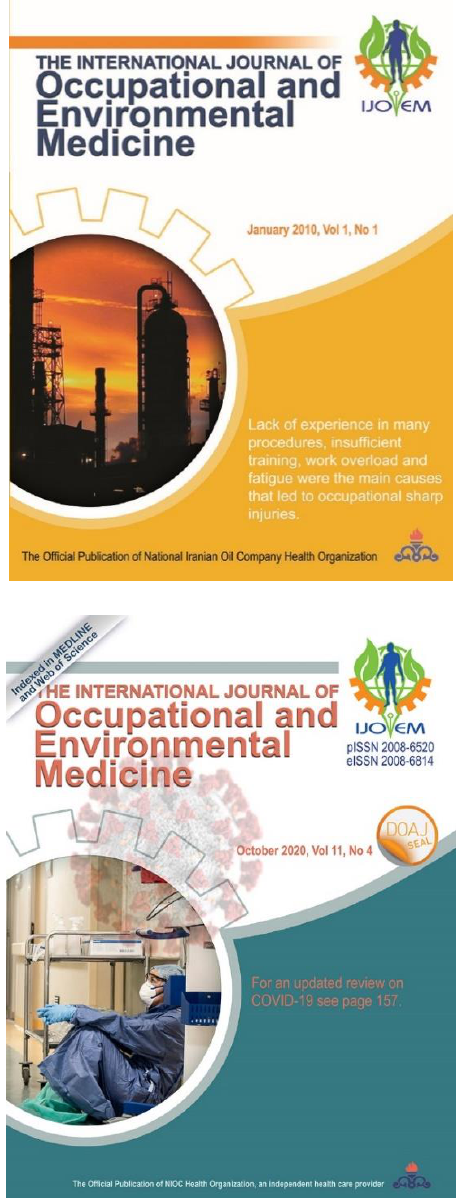
Fig. 1 Cover images of the inaugural and